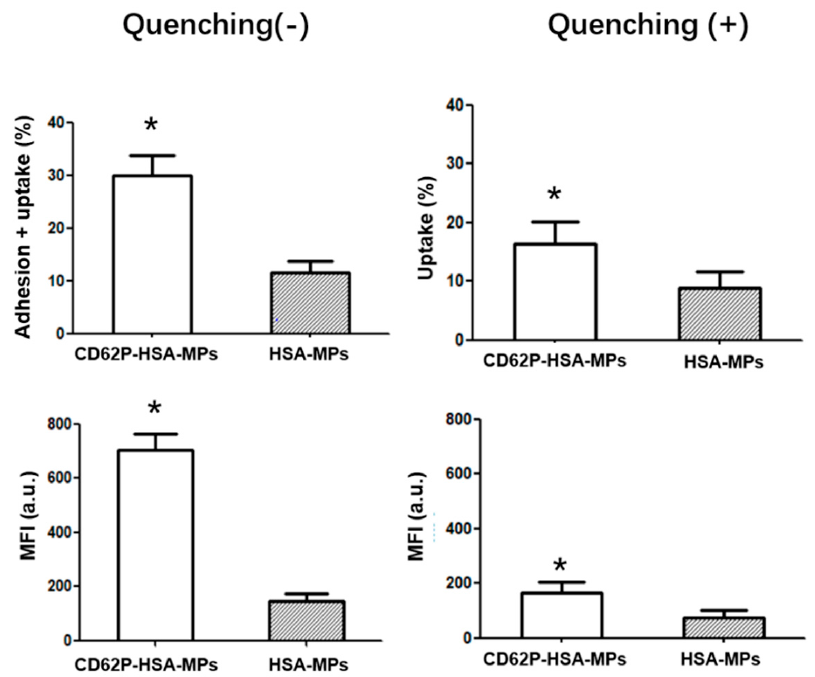
Figure 5. Adhesion vs. cellular uptake of anti-CD62P-HSA-MPs and HSA-MPs in A549 cells analyzed by flow cytometry. Adhering particles are excluded by quenching with Trypan blue. Upper graphs show the percentage of events in the A549 cell population with enhanced fluorescence in the FITC channel. Lower graphs show the corresponding Mean Fluorescence Intensities. * p < 0.05.